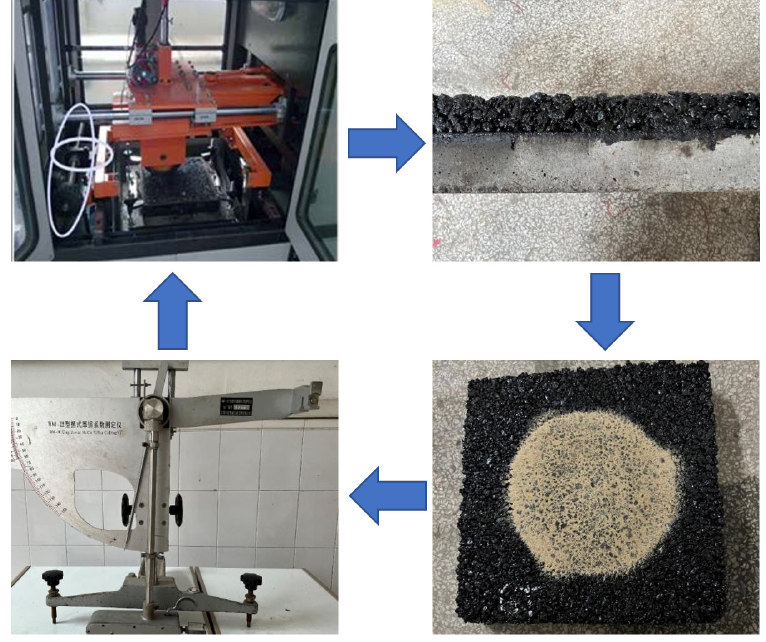
Figure 6. Kneading test process.